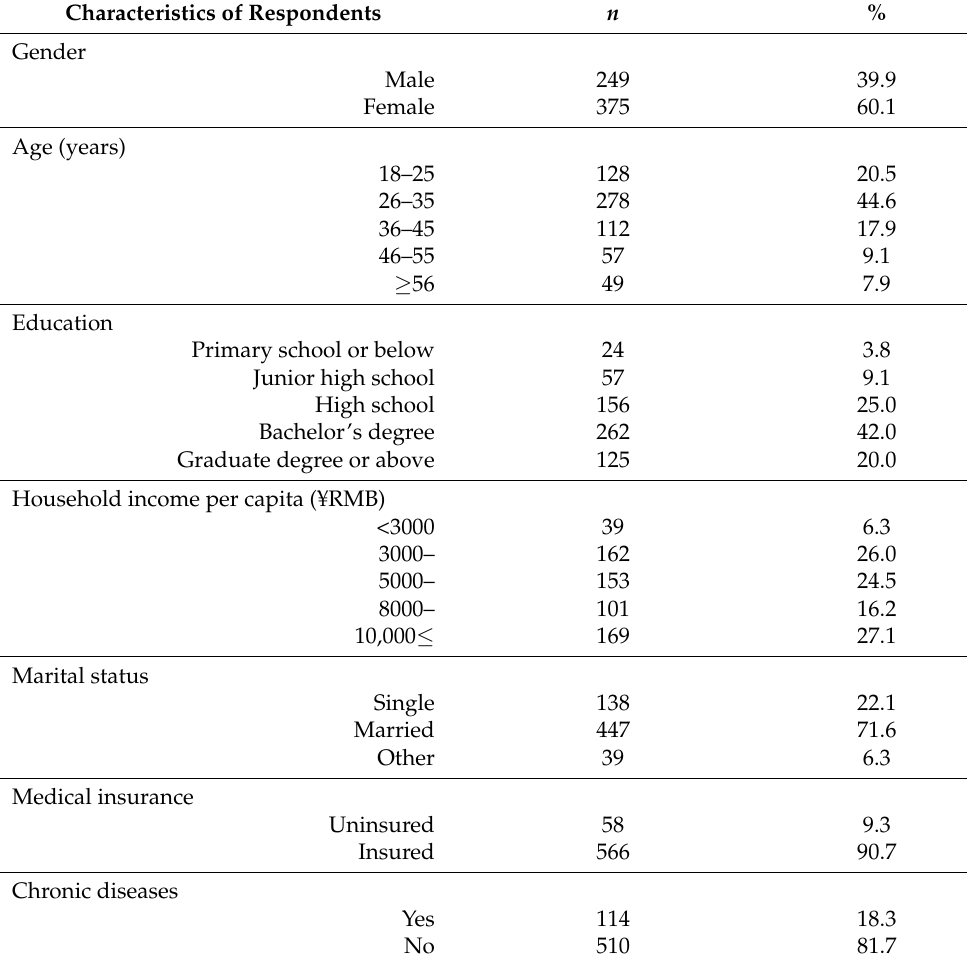
Table 2. Characteristics of